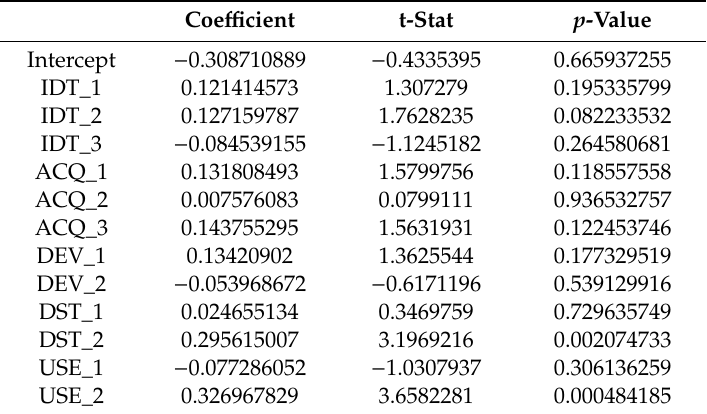
Table 5. Result of linear regression analysis for the initial model.